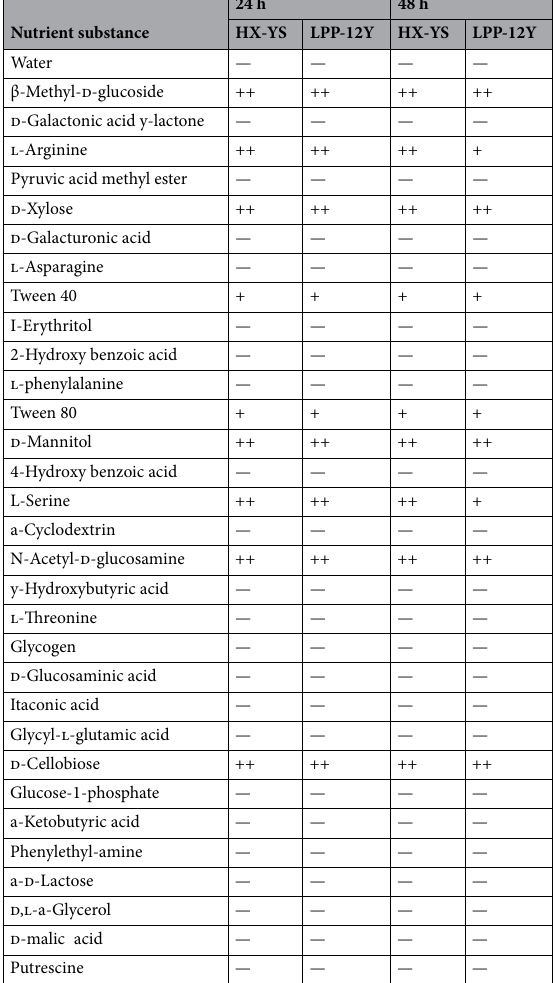
Table 1. Utilization of 32 different carbon and nitrogen sources by HX-YS and LPP-12Y. “++”indicates that the strain can make full use of the nutrients of the pore plate; “+”indicates that the strain can’t make full use of the nutrients of the pore plate; “—”indicates that the strain can’t use the nutrients of this pore